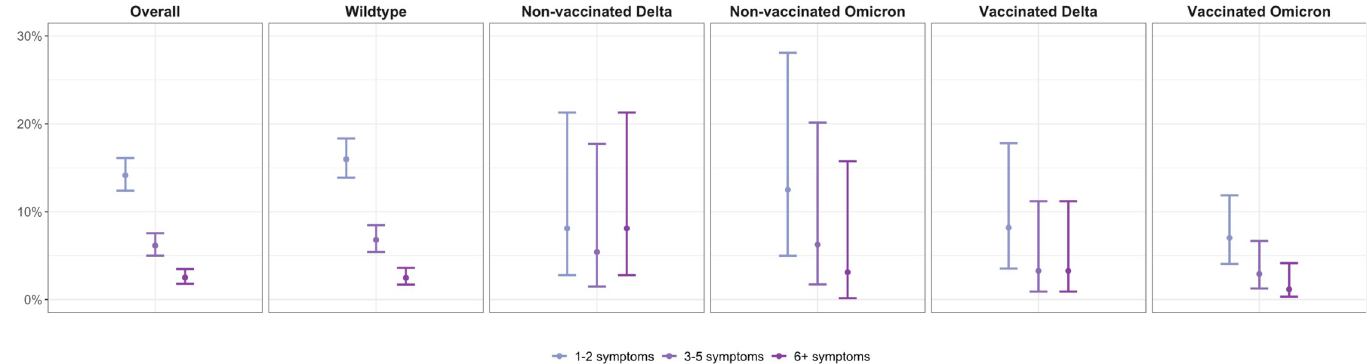
Fig 2. Prevalence of post COVID-19 condition six months after infection at different levels of severity in terms of symptom count. Analyses were stratified by SARS-CoV-2 variant and vaccination status. Points represent point estimate and error bars represent 95% Wilson confidence intervals for estimated proportions.